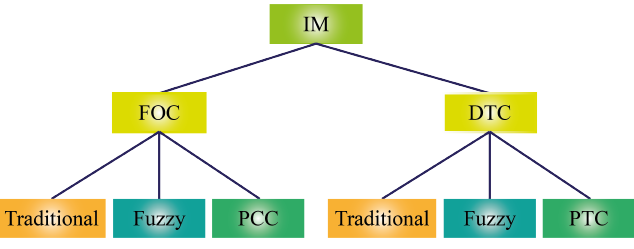
Figure 1. IM control